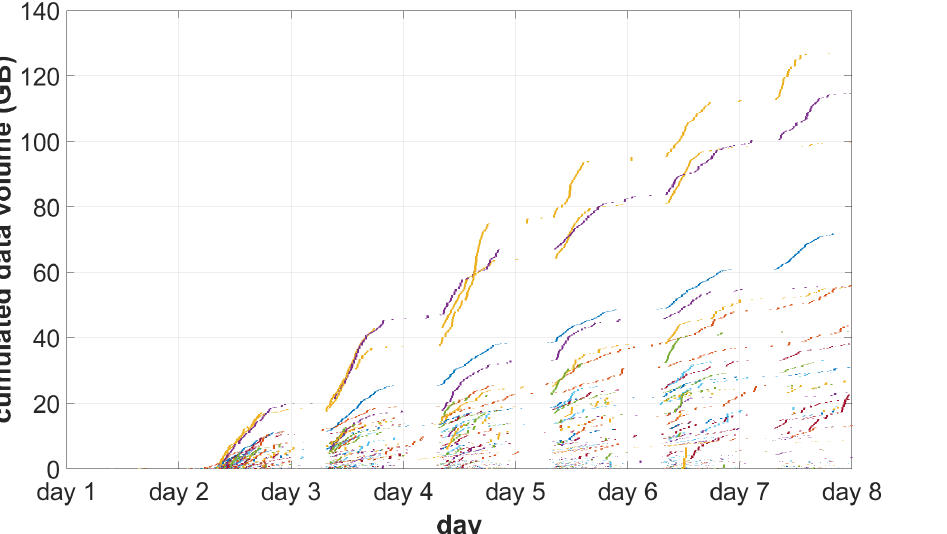
Figure 7. Cumulative traffic visualization during test days. Each imaging device’s model activity is composed of segments corresponding to a single series. The colors match Figure